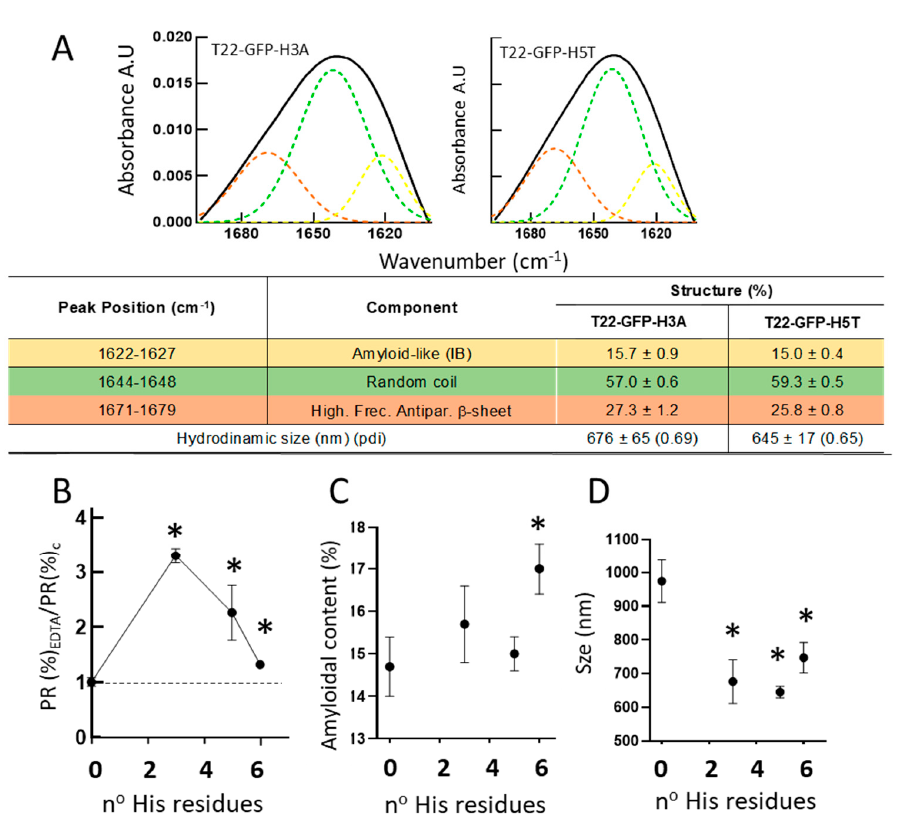
Figure 4. Structural impact of the His residue number on IB properties. ( A ) Amide I band (black) and components resulting from deconvolution (in colors), for two alternative proteins. At the bottom, deconvolution results of the spectra analyses as percentages of the components within each IB. Colored peak components match with table rows. ( B ) Protein release from IBs in the presence of EDTA (53 mM) relative to protein release in the absence of EDTA, represented versus the number of histidine residues in the C ‐ terminal tag. IBs were formed by untagged T22 ‐ GFP, by T22 ‐ GFP ‐ H6 or by their derivatives with 3 and 5 His residues at the C ‐ terminus. ( C ) Amyloidal content versus His residue number in the tag. ( D ) IB size versus His residue number in the tag. * Statistically different respect to the non ‐ tagged T22 ‐ GFP ( p < 0.1).